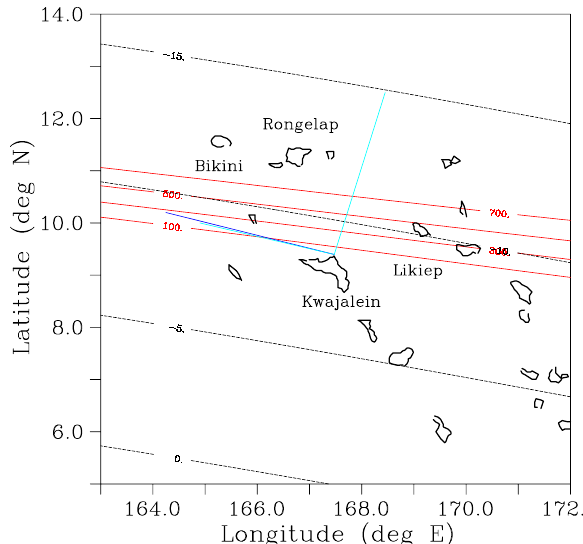
Fig. 1. Experiment geometry. The instrumented and chemical re- lease rocket trajectories are shown, respectively, by the blue and cyan lines radiating from Roi Namur at the northern tip of Kwa- jalein Atoll. Solid red contours represent the altitude in kilometers for field aligned backscatter from the Altair radar on Roi Namur. Dashed contours indicate the geomagnetic dip angle in